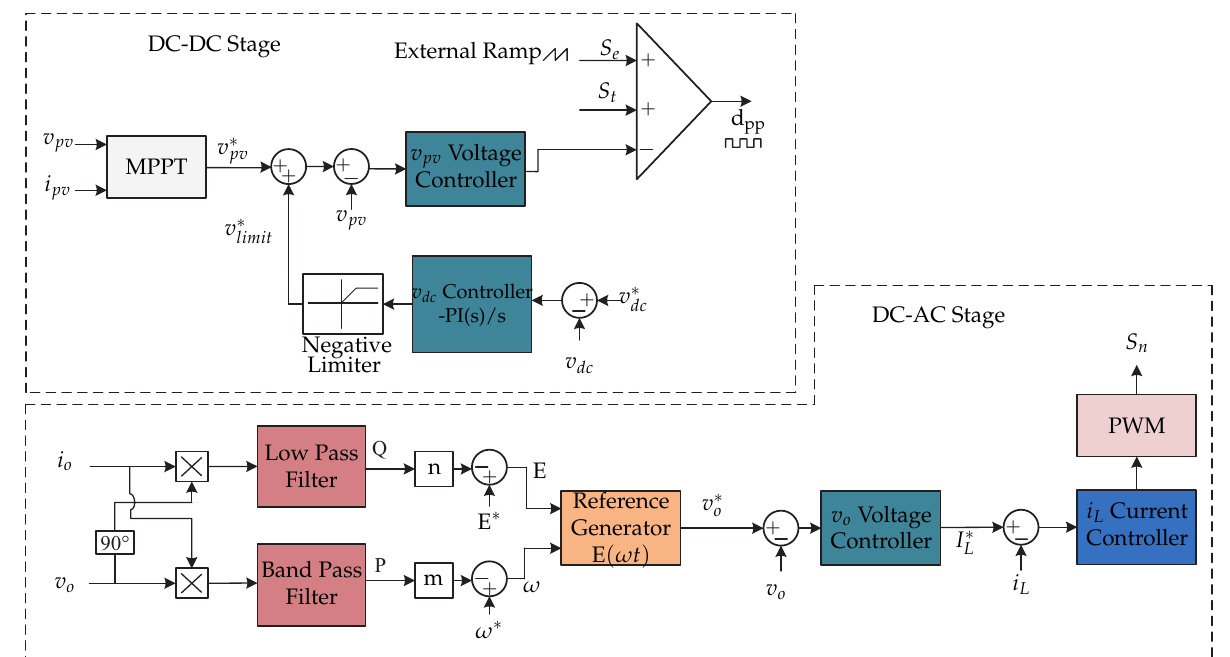
Figure 40. Control strategy proposed in [74,75].